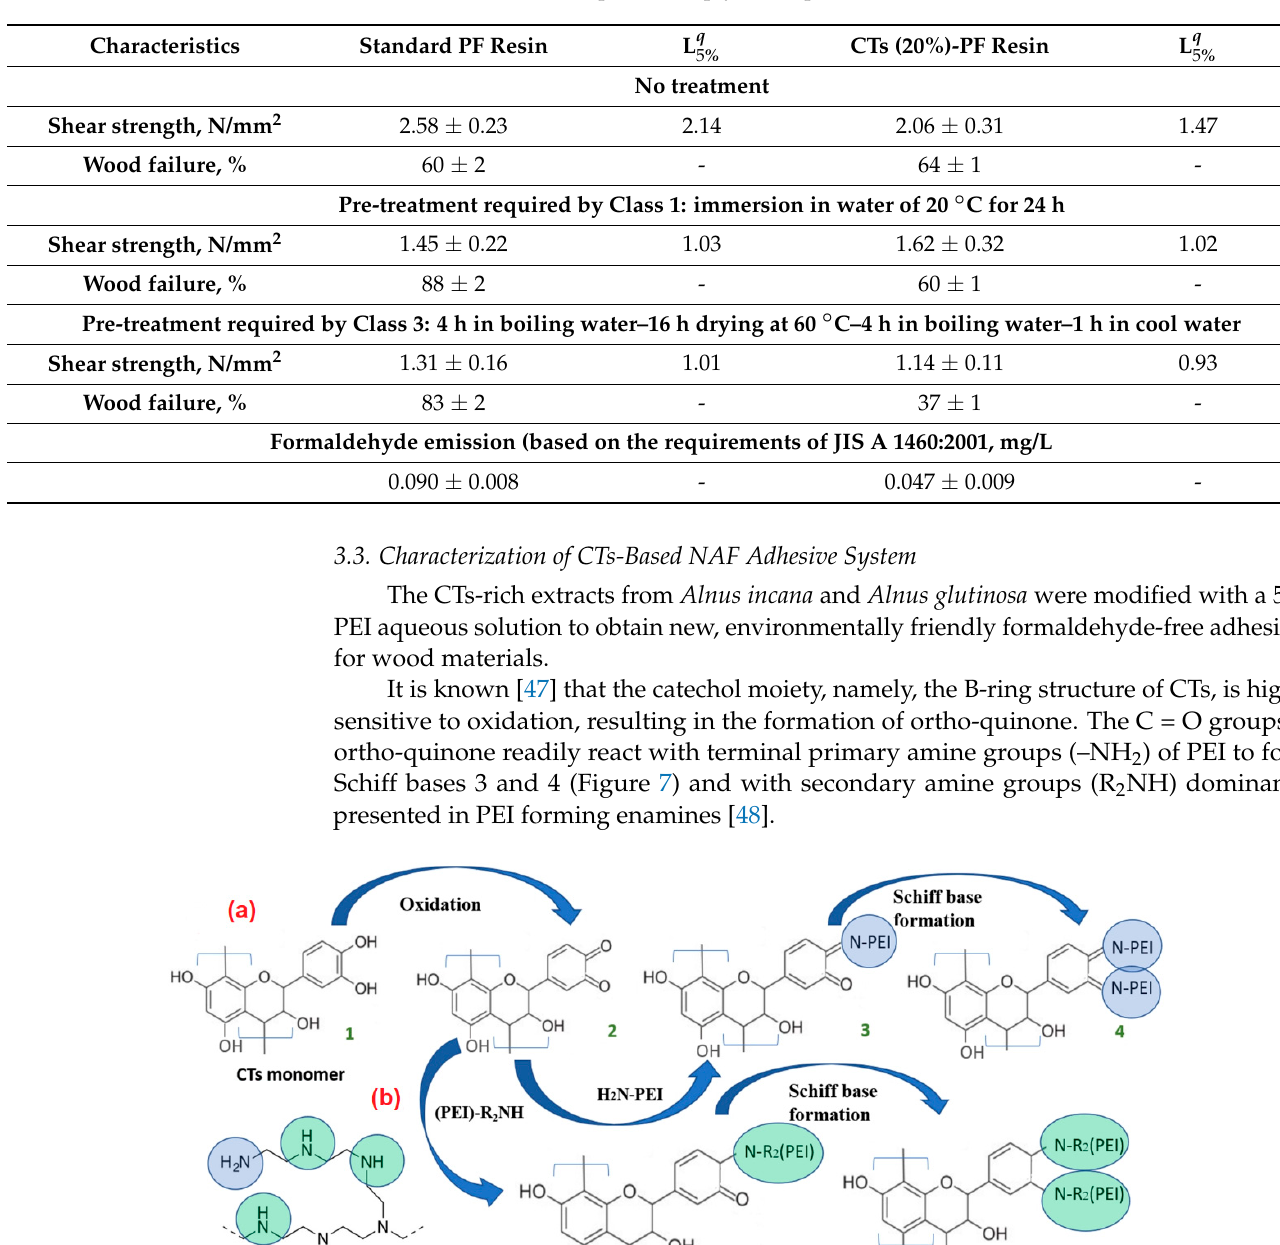
Table 2. Shear strength, wood failure, and formaldehyde emission of the plywood produced with CTs (20%)-PF resin, in comparison to plywood, produced with a standard PF resin.